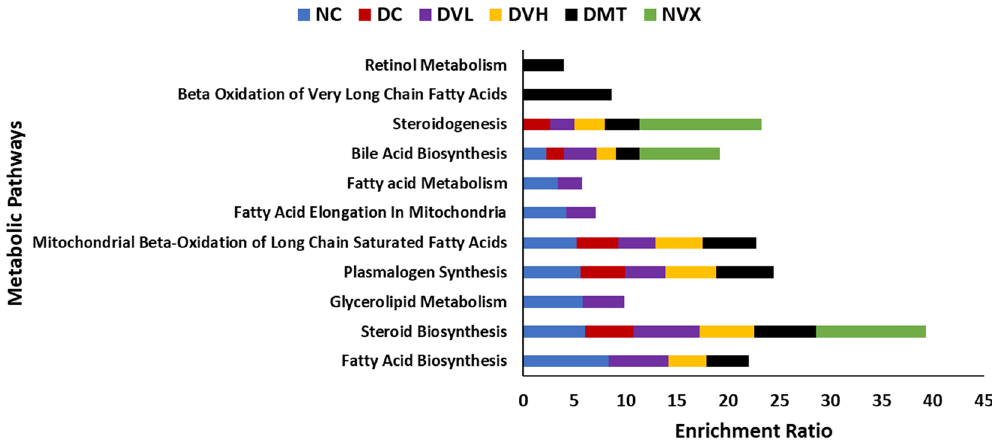
Figure 10. Enrichment ratio of identified pathways in experimantal muscle tissues. NC = normal rats, DC = diabetic control, DVL = diabetic rats + vanillin (150 mg/kg b.w), DVH = diabetic rats + vanillin (300 mg/kg